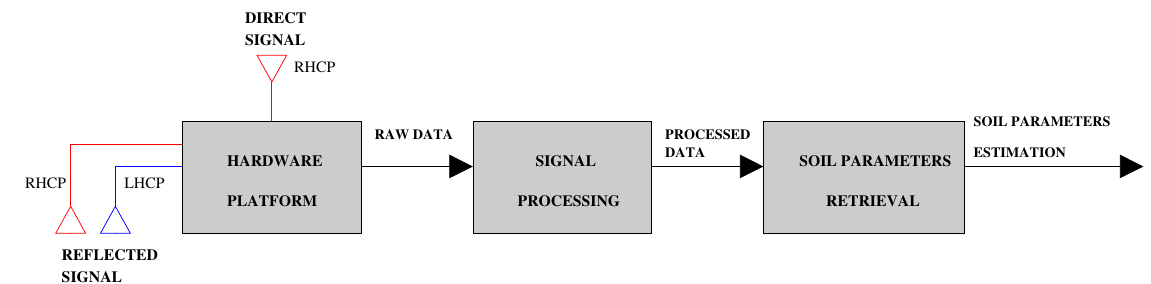
Figure 1. High-level information flow and the three layers of the prototype